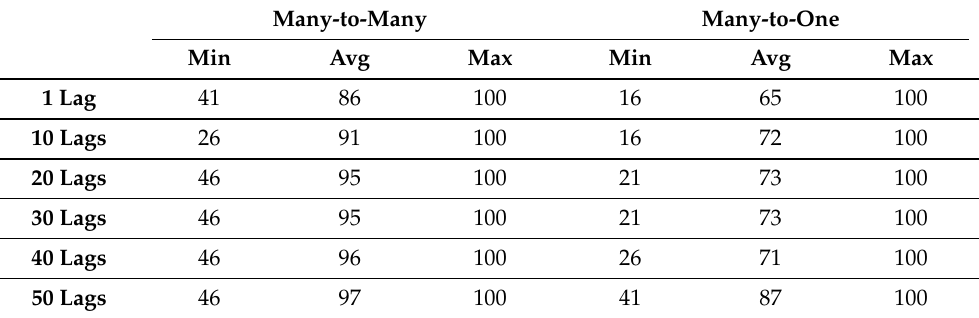
Table 3. The training convergence time (epochs) for LSTMTF, computed with respect to the number of lags, for (cid:101) = 1% and P =